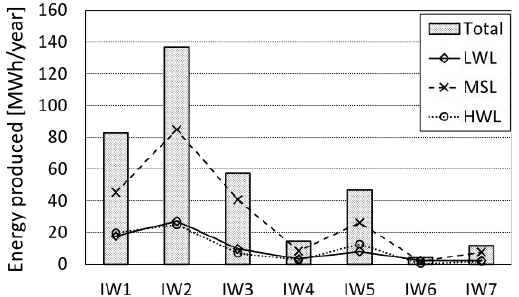
Fig. 12. Energy produced by the OWC component for each water depth tested and total.